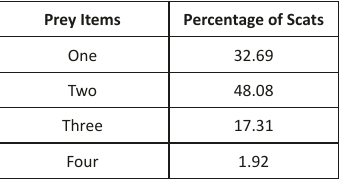
Table 1. Occurrence of number of prey in the scats of the jackal in Gir National Park and Sanctuary, India.